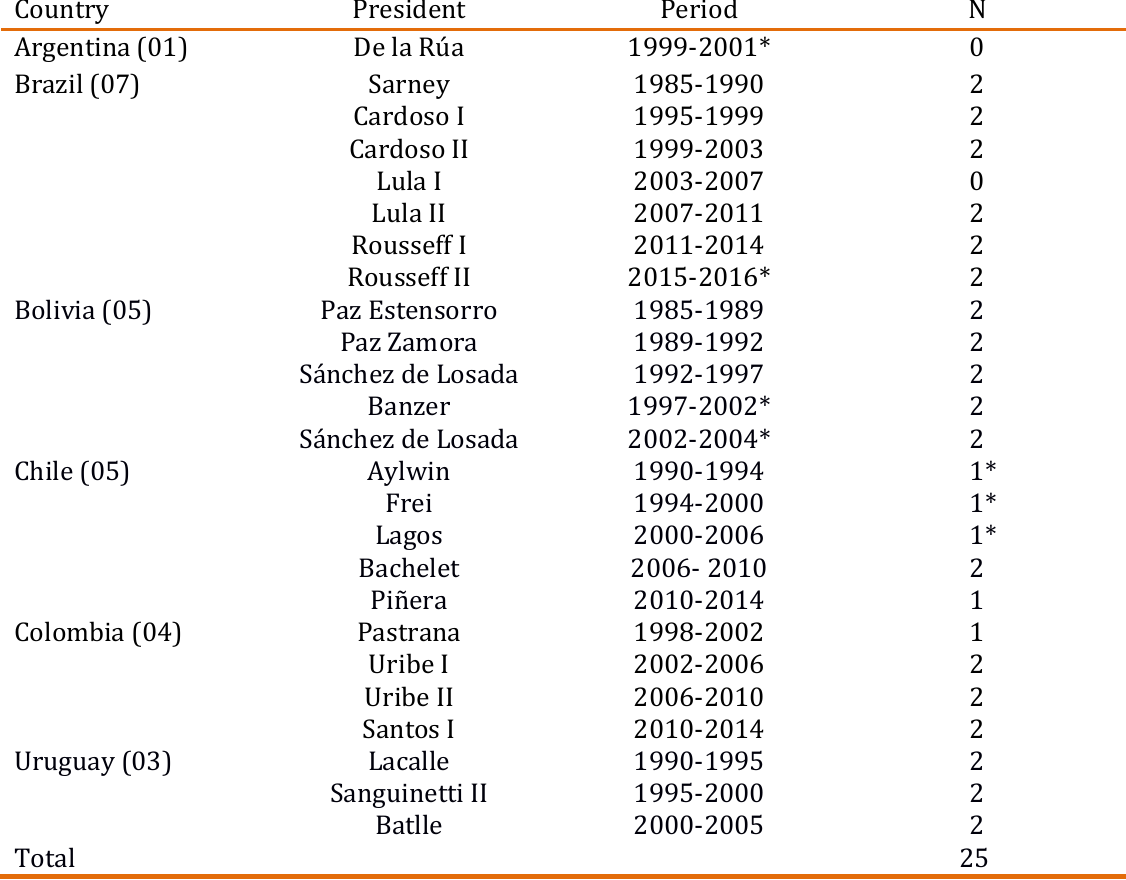
Table 03. Coalition cabinets in bicameral polities in Latin America (concluded cabinets)